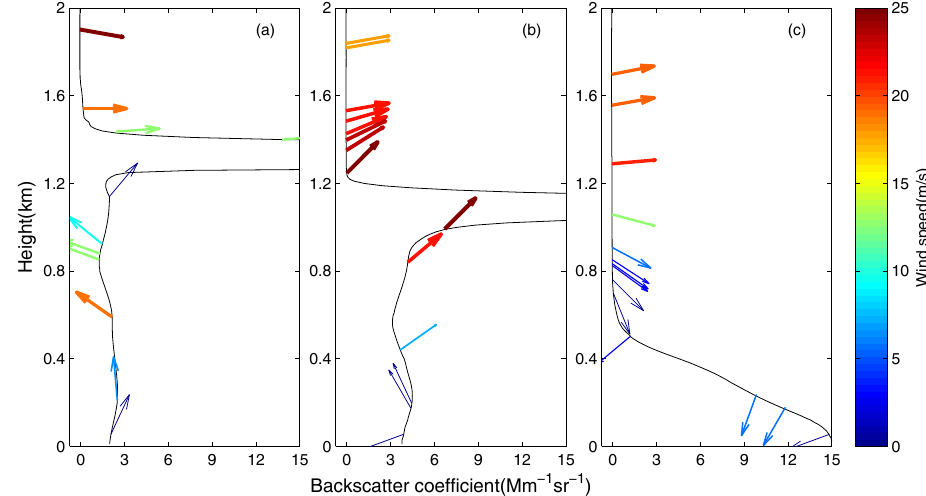
Figure 10. Attenuated backscattering coefficients and wind vectors for the period 21–26 October at (a) 08:00LT on 21 October, (b) 08:00LT on 22 October, and (c) 08:00LT on 25